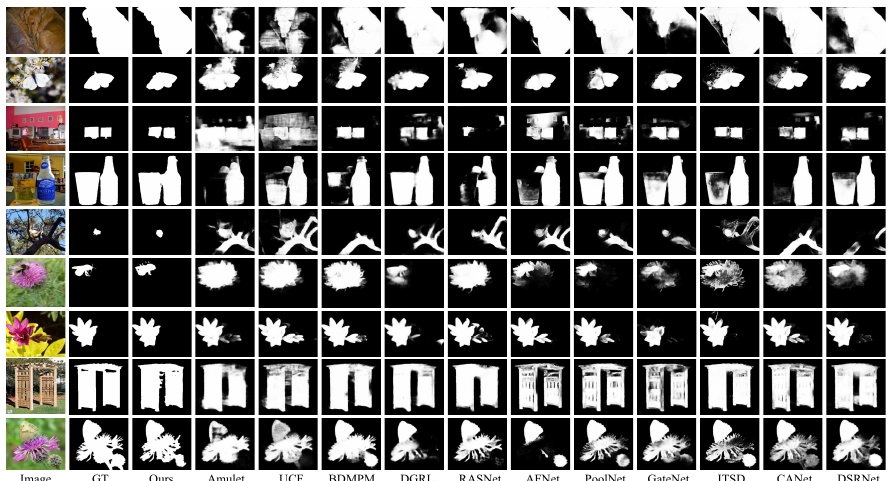
Figure 7. Qualitative comparison of 11 state-of-the-art deep SOD methods and our GSCINet method. As can be seen, the proposed method (ours) is the closest to ground truth (GT).